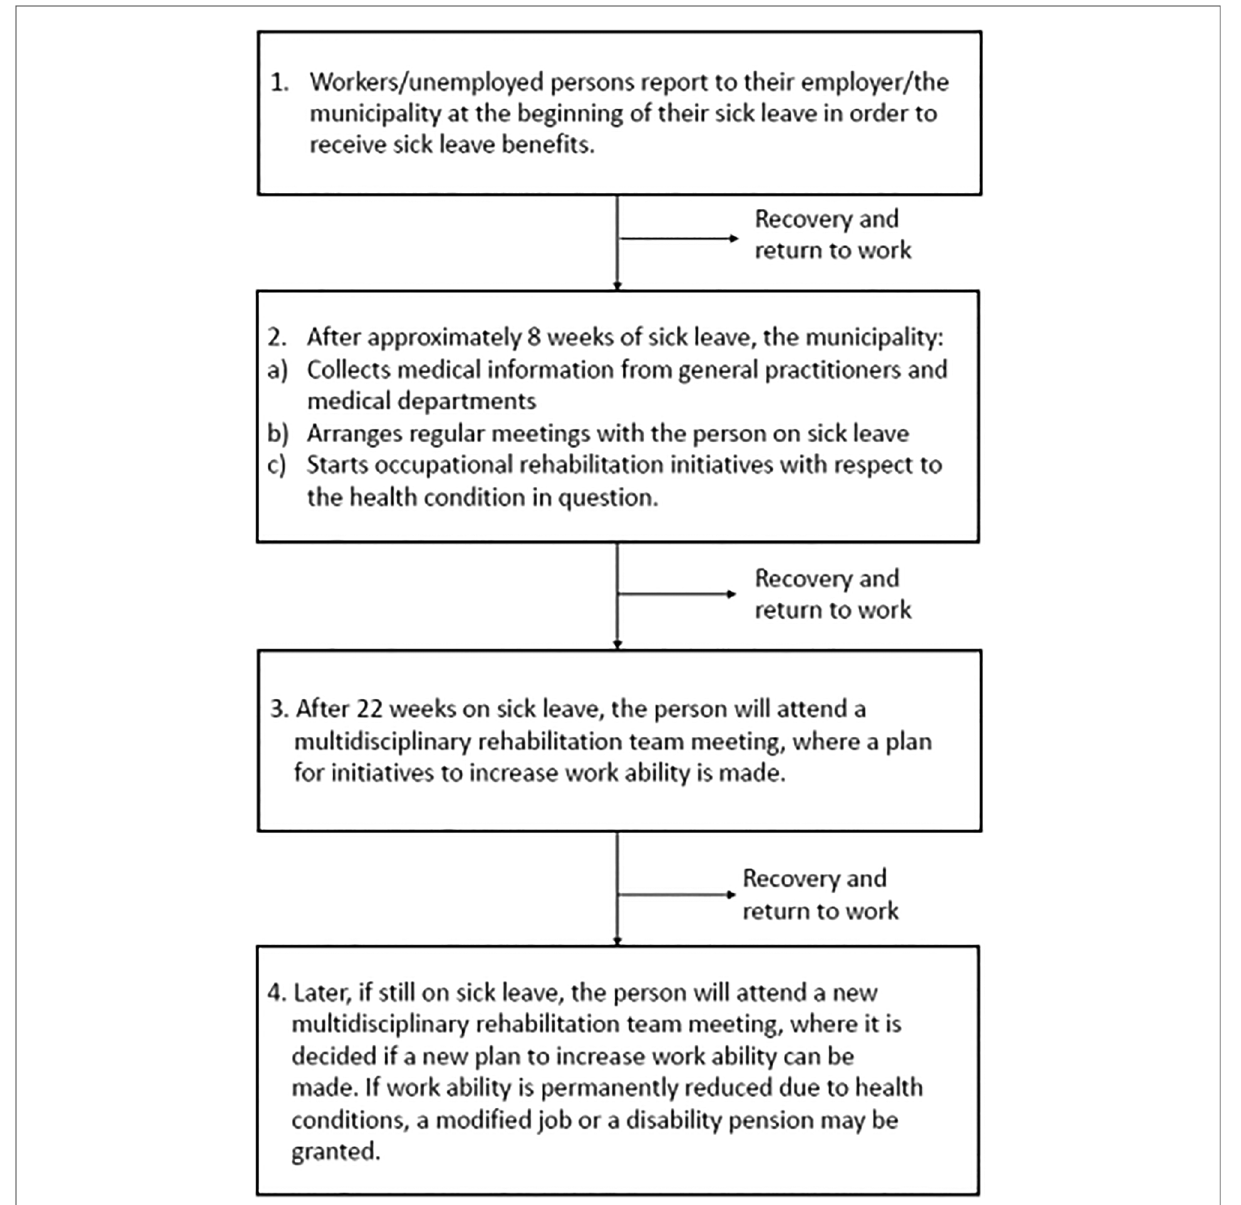
FIGURE 1 Occupational rehabilitation for persons on sick leave bene fi ts in Danish